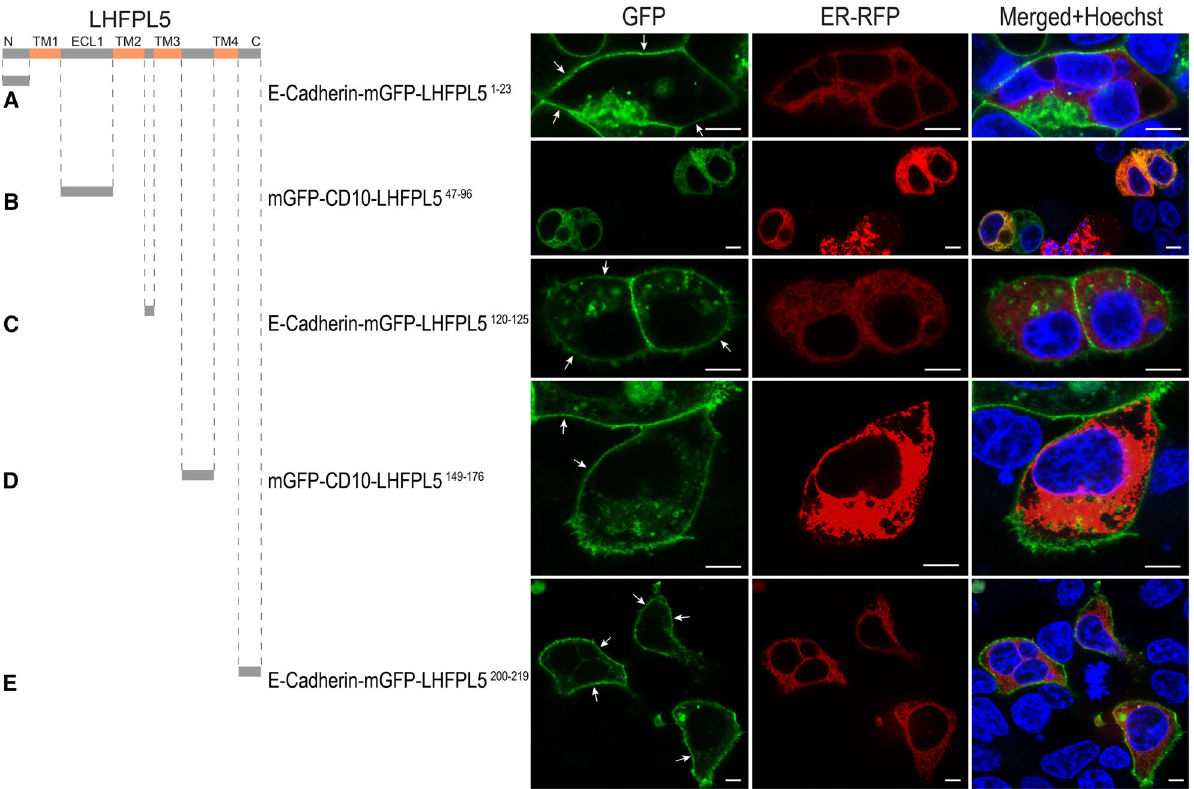
Figure 3. E-Cadherin- and CD10-based reporters confirm intracellular retention quality of the extracellular loop 1, LHFPL5 47–96 . ( A ) N-terminus of LHFPL5, residues LHFPL5 1–23 , when fused to the C-terminus of E-Cadherin-mGFP does not preclude reporter PM localization, confirming result obtained with AGR. ( B ) When extracellular loop 1 fragment LHFPL5 47–96 was fused to C-terminus of mGFP-CD10 reporter, no detectable PM labeling was observed. These results confirm the data acquired using AGR, corroborating the ability of the LHFPL5 47–96 to halt trafficking to the PM. ( C–E ) Intracellular loop 1 fragment LHFPL5 120–125 ( C ), extracellular loop 2 fragment LHFPL5 149–176 ( D ), and C-terminus fragment LHFPL5 200–219 ( E ) did not prevent corresponding reporters E-Cadherin-mGFP-LHFPL5 120–125 ( C ), mGFP-CD10-LHFPL5 149–176 ( D ), and E-Cadherin-mGFP-LHFPL520 200–219 ( E ) trafficking to the PM, confirming the result obtained by AGR. Scale bars: 10